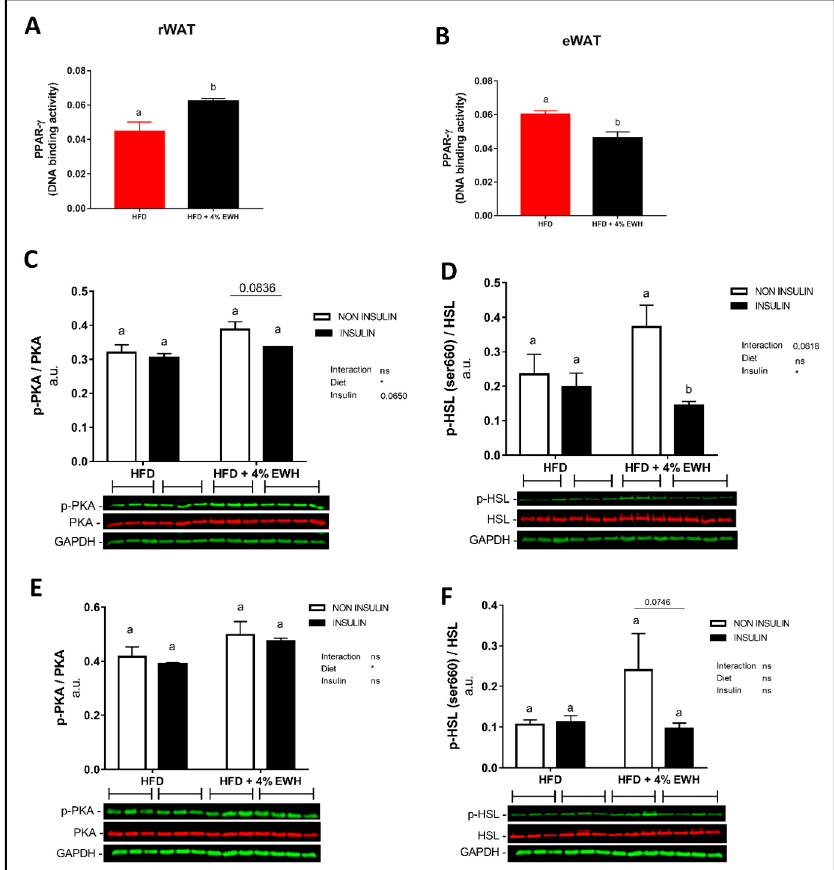
Figure 1. EWH effects in WAT of Sprague Dawley rats fed EWH for 6 weeks (Protocol 1). PPAR γ DNA binding activity in rWAT ( A ) and eWAT ( B ). Data expressed as mean ± SEM and analyzed by two-tailed t-test (n = 6–7). PKA, p-PKA, HSL and p-HSL protein abundance in rWAT ( C , D ) and eWAT ( E , F ). Data expressed as mean ± SEM and analyzed by two-way ANOVA (n = 3–4). Bars with different letters indicate p < 0.05. EWH, egg white hydrolysate; PKA, protein kinase A; PPAR γ , Peroxisome proliferator-activated receptor gamma; HSL, hormone sensitive lipase; WAT, white adipose tissue; rWAT, retroperitoneal WAT; eWAT, epididymal WAT. Table 2. Resistin and adiponectin concentration in plasma, epididymal and retroperitoneal adipose tissue in Sprague Dawley rats treated with HFD+4% EWH for 6 weeks (Protocol 1). Data expressed as mean ± SEM and analyzed by two tailed t-test (n = 6–7).